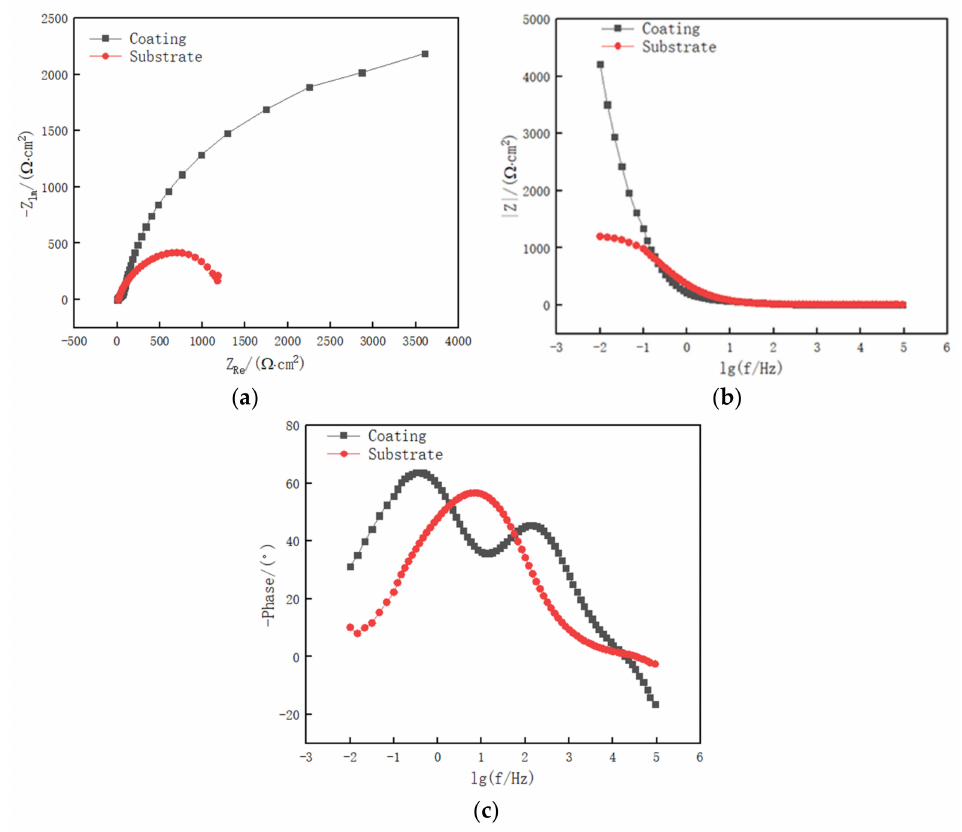
Figure 6. EIS diagram of the 27SiMn matrix and Fe-based alloy cladding layer in 3.5% NaCl solution: ( a ) Nyquist; ( b ) Bode of impedance; ( c ) Bode of the phase